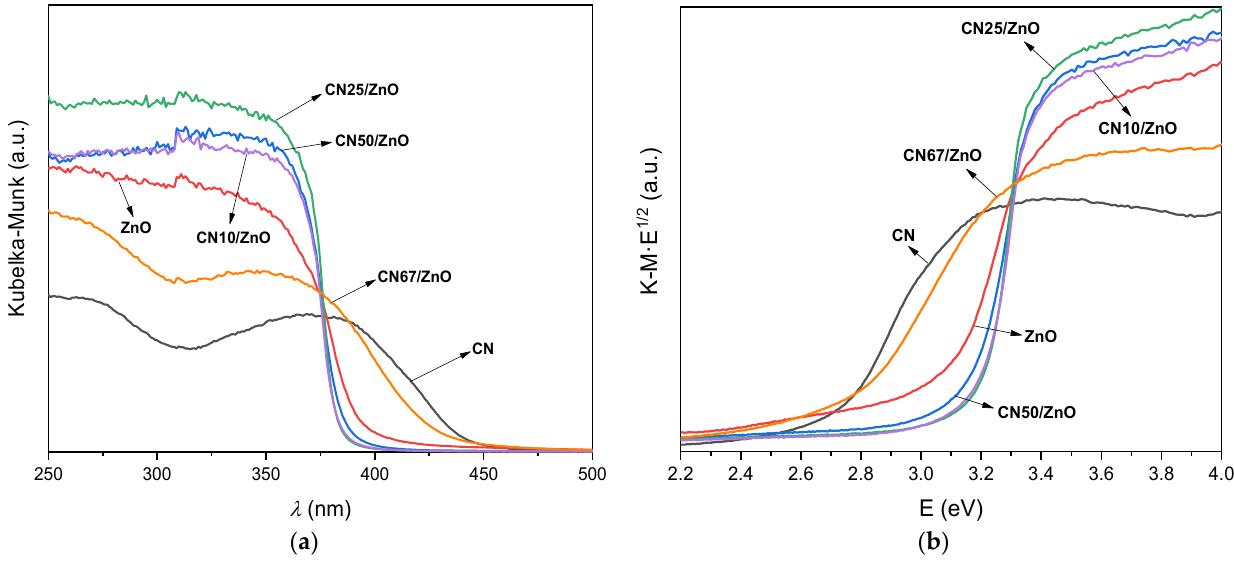
Figure 5. ( a ) UV–Vis spectra and ( b ) Tauc’s plots vs. energy (eV) of pure CN, pristine ZnO, and CN/ZnO composites.